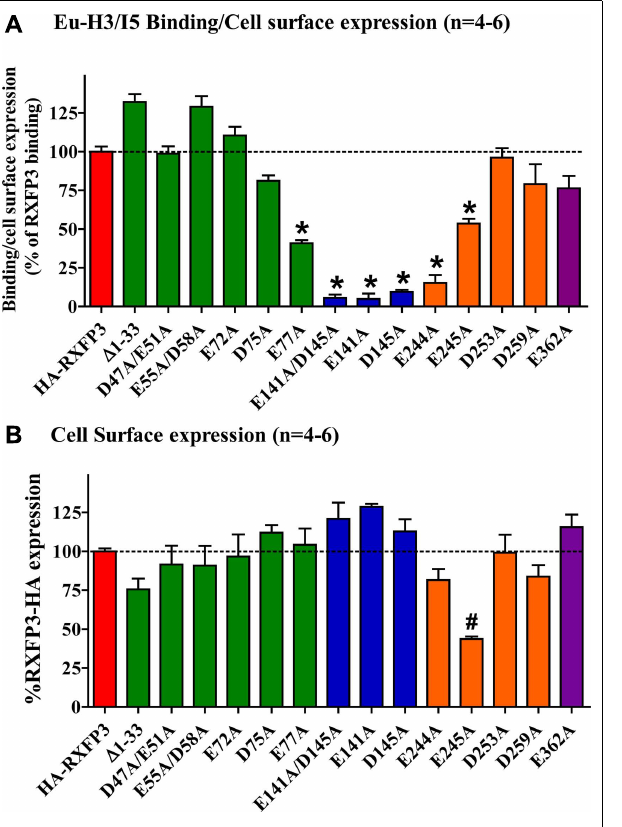
FIGURE 3 | (A) Eu-H3/INSL5 binding to mutant receptors expressed on the surface of cells. Data are expressed as a ratio of specific Eu-H3/I5 binding to the cell surface expression ( B ) of each construct and are normalized to HA-RXFP3 binding. (B) Cell surface expression of the various RXFP3 mutant receptors compared to HA-RXFP3. All data are the mean of triplicate determination from 4 to 8 independent experiments. * p < 0.001 vs HA-RXFP3, # p < 0.01 vs HA-RXFP3.